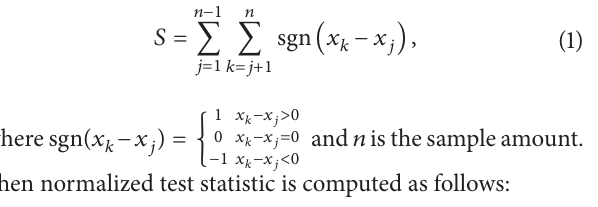
Figure 2: Run theory and drought